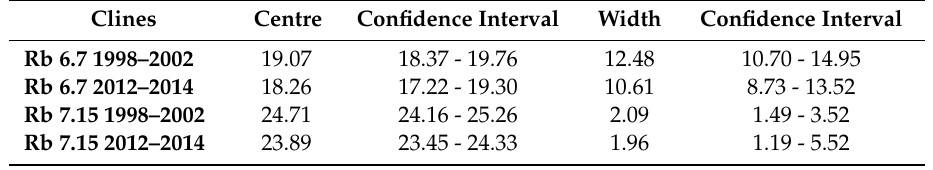
Table 1. Maximum likelihood estimates of cline centre position and cline width for Rb 6.7 (logistic regression model) and Rb 7.15 (scaled logistic regression model) and respective confidence intervals.